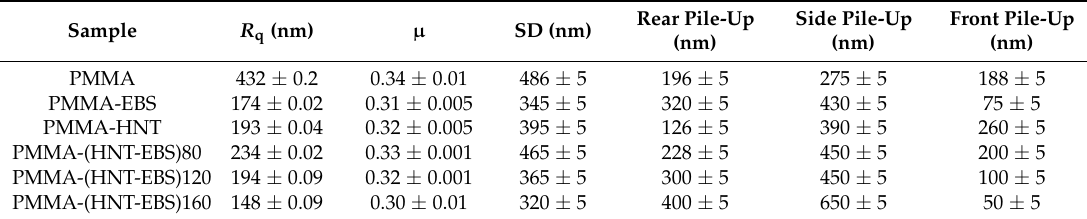
Table 2. The root mean square (RMS) roughness, the coefficient of friction, the scratch penetration depth and the scratch pile-up measured for all